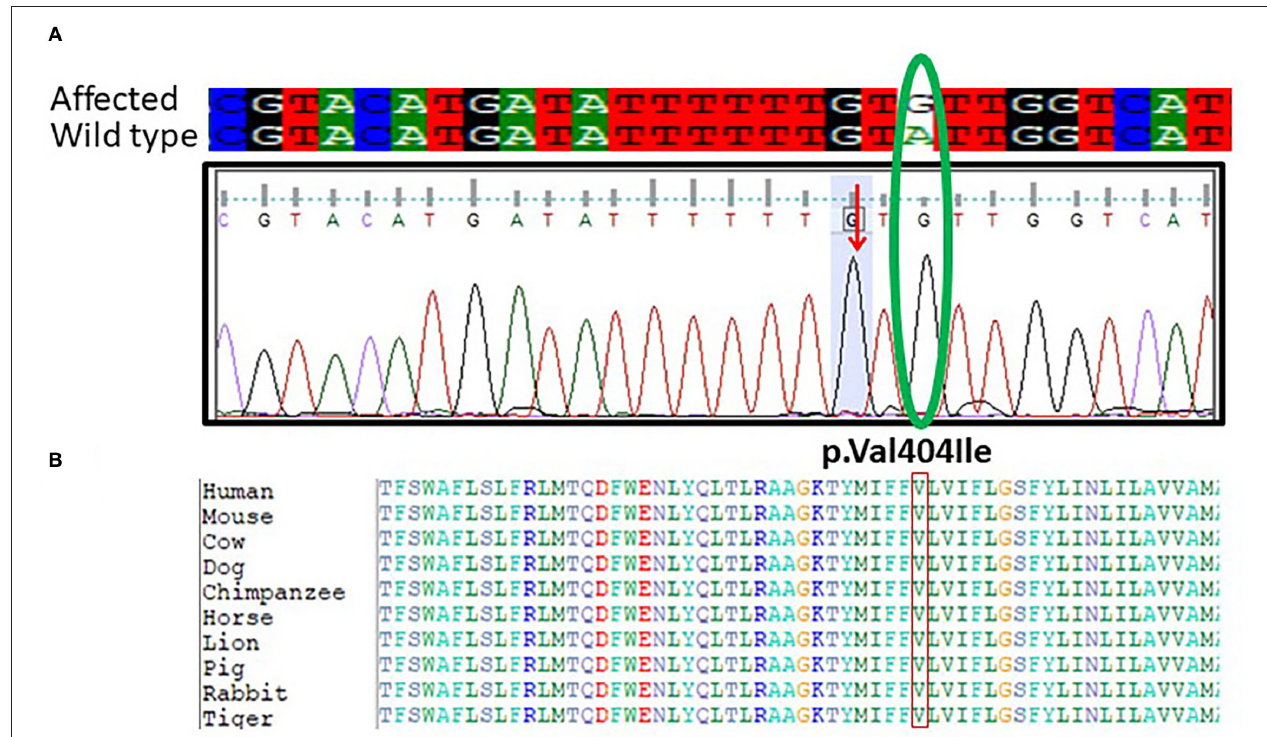
FIGURE 3 | (A) Chromatogram of Sanger sequencing showing the c.1212A > G p.Val404Ile in 10 unrelated patients SCN1A gene from the cohort of 25 epileptic sporadic patients. The green oval is showing the change in the base pair in mutant and while type sequence. (B) Protein alignment of different species was done to show the highly conserved amino acid variants p.Val404Ile SCN1A gene highlighted in all species.